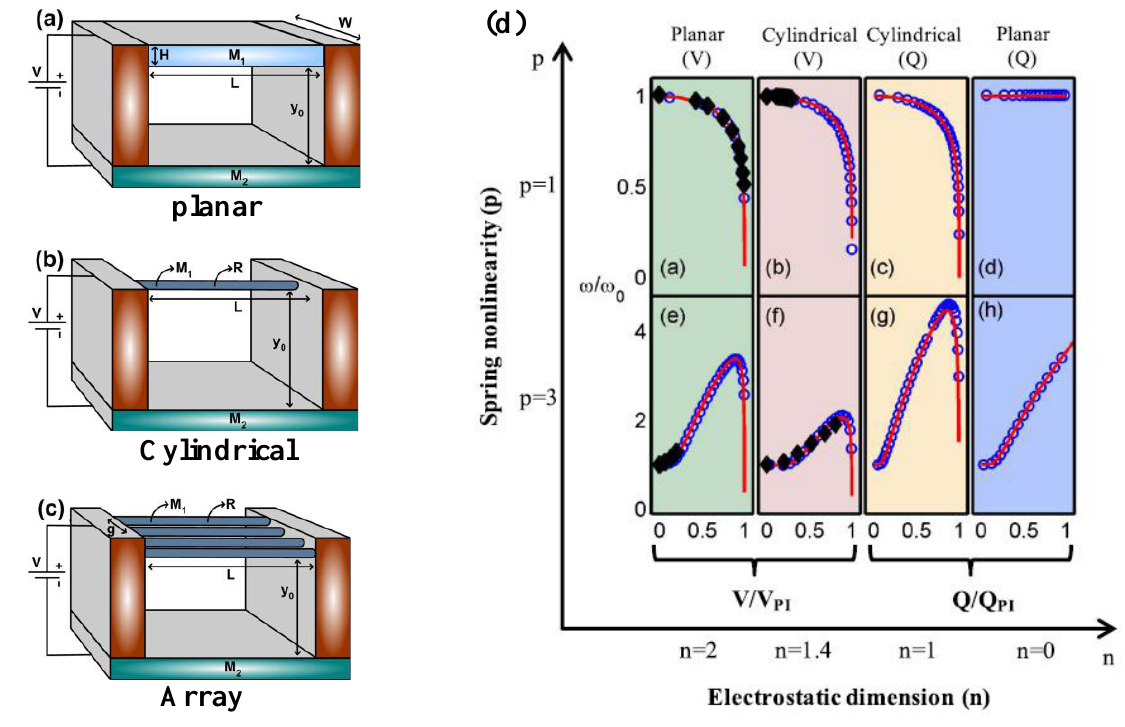
Figure 21. General electrode geometries for micro- and nano-mechanical resonators reported by Jain and Alam [288]. ( a ) Classical planar electrode; ( b ) Cylindrical electrode; ( c ) array of cylinders; ( d ) Resonant frequency as a function of (V/Q) with scaling effect. Reused with permission from